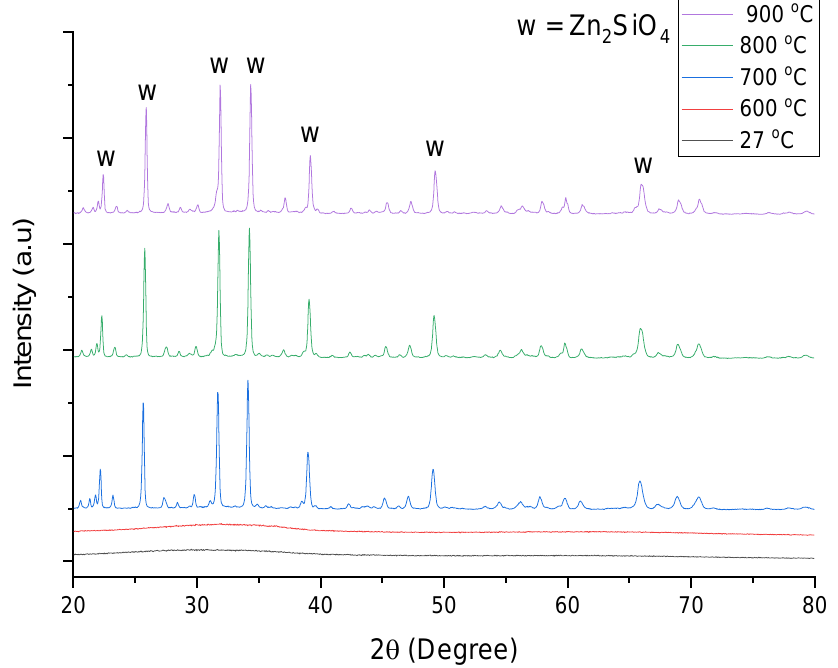
Figure 2. X-ray diffraction (XRD) pattern of 55ZnO–5B 2 O 3 –40SLS glass and glass-ceramic sintered at various various temperatures.